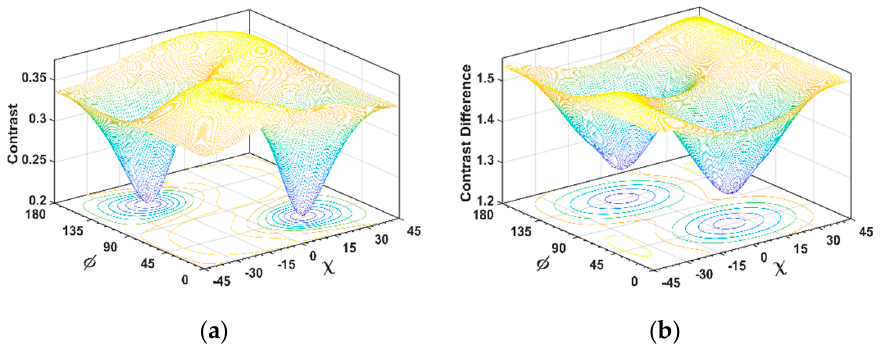
Figure 3. Strong temporal decorrelation-affected data: ( a ) A 3D view plot of polarimetric TomoSAR focusing capability; ( b ) polarization TomoSAR dispersion obtained by subtracting Figure 3a from Figure 1.